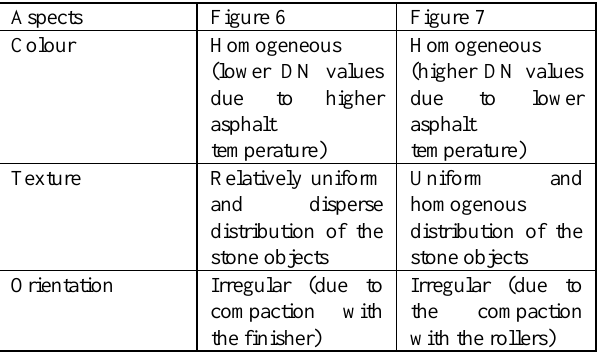
Table 1. Comparison of observations regarding colour, texture and